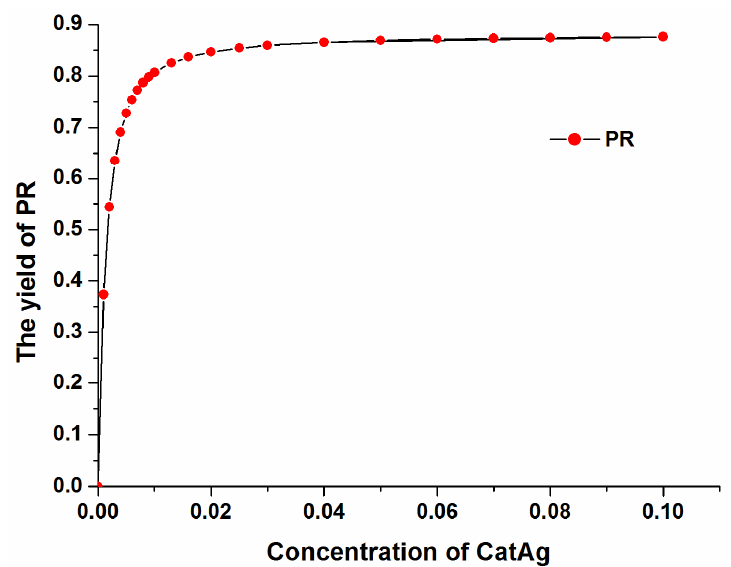
Figure 13. The yield of product (PR) varies with the catalyst (CatAg) concentration.